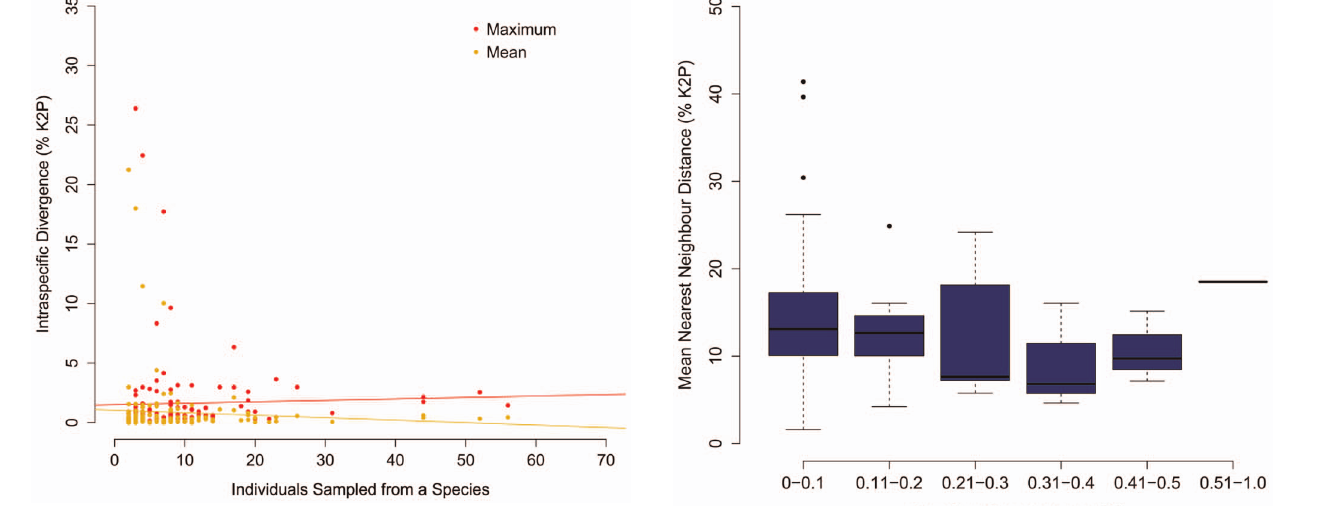
Figure 3. The relationship between COI distance and sample size within species. Maximum and mean intraspecific divergences (% K2P) at COI plotted against the number of individuals analyzed for 147 species of Canadian marine molluscs. The regression between sample size and mean divergence is insignificant (P=0.38; R 2 =0.005) as well as the regression between sample size and maximum divergence (P=0.72; R 2 =0.0009).